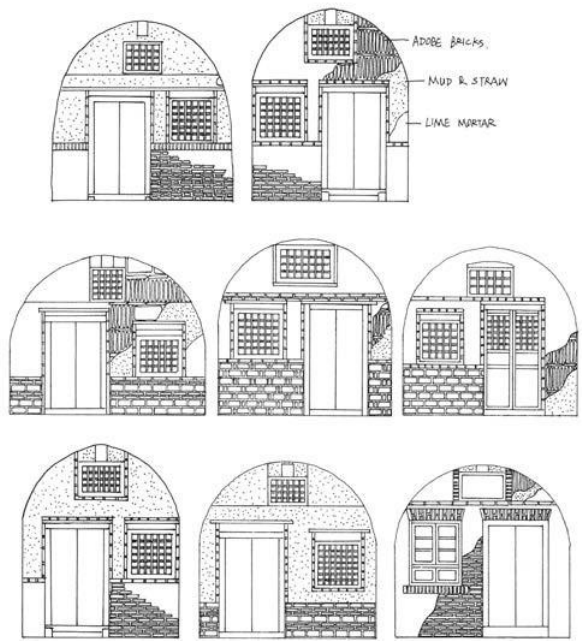
Figure 8. Typological study of the cave faces (adobe bricks covered with lime mortar)